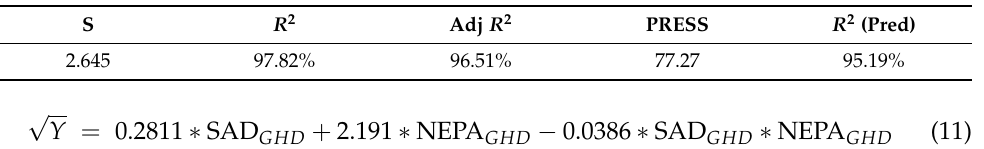
Table 9. Predictive ability and fit of Get hot drink PLSR